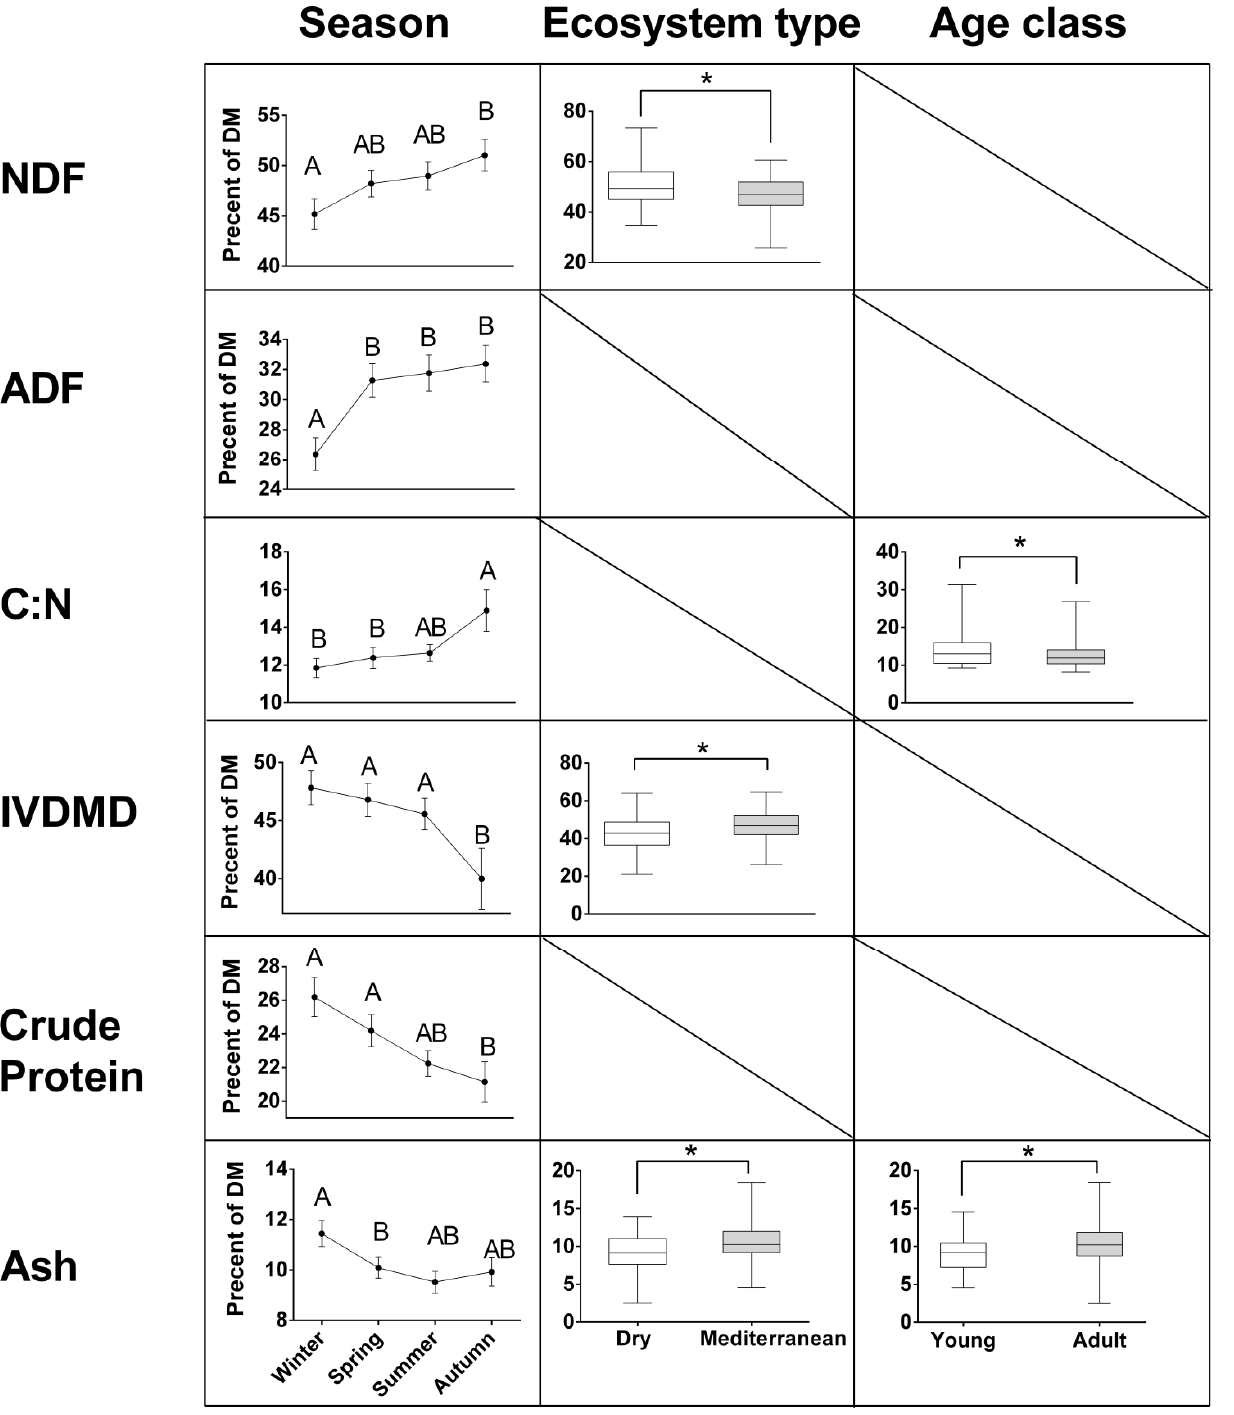
Figure 5. Contents of nutritional constituents (percent of dry matter; DM, except for C:N ratio) in mountain gazelle rumens, estimated with near-infrared spectrometry (NIRS). Means ( ± standard error) are presented for seasons, significantly different if not connected by the same letters (Tukey’s post- hoc; p < 0.05). Boxplots depict the median and interquartile range, by ecosystem type and age class, with significantly different levels connected by * ( p < 0.05). Numerical results are presented in Tables 5 and 6.